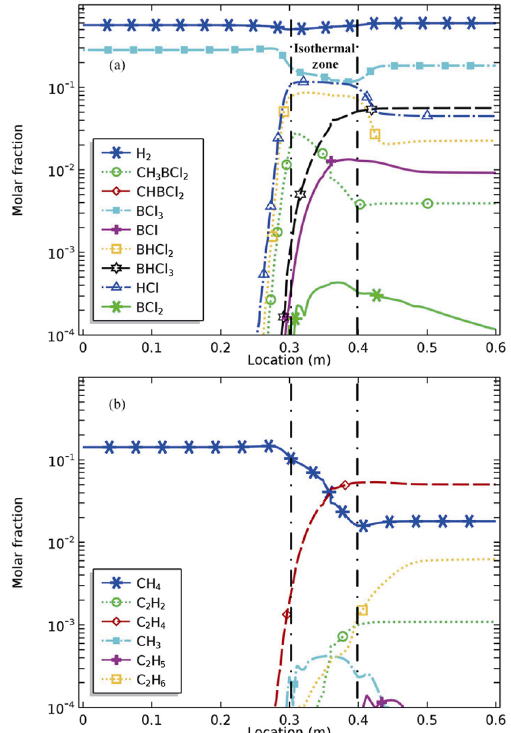
Fig. 4 Plots of the gas-phase compositions for (a) boron and (b) carbon elements along the reactor height for deposition temperature of 1000 ℃ , total pressure of 12 kPa, total gas flow rate of 210 sccm, In_BCl 3 is 2/7, and In_CH 4 is